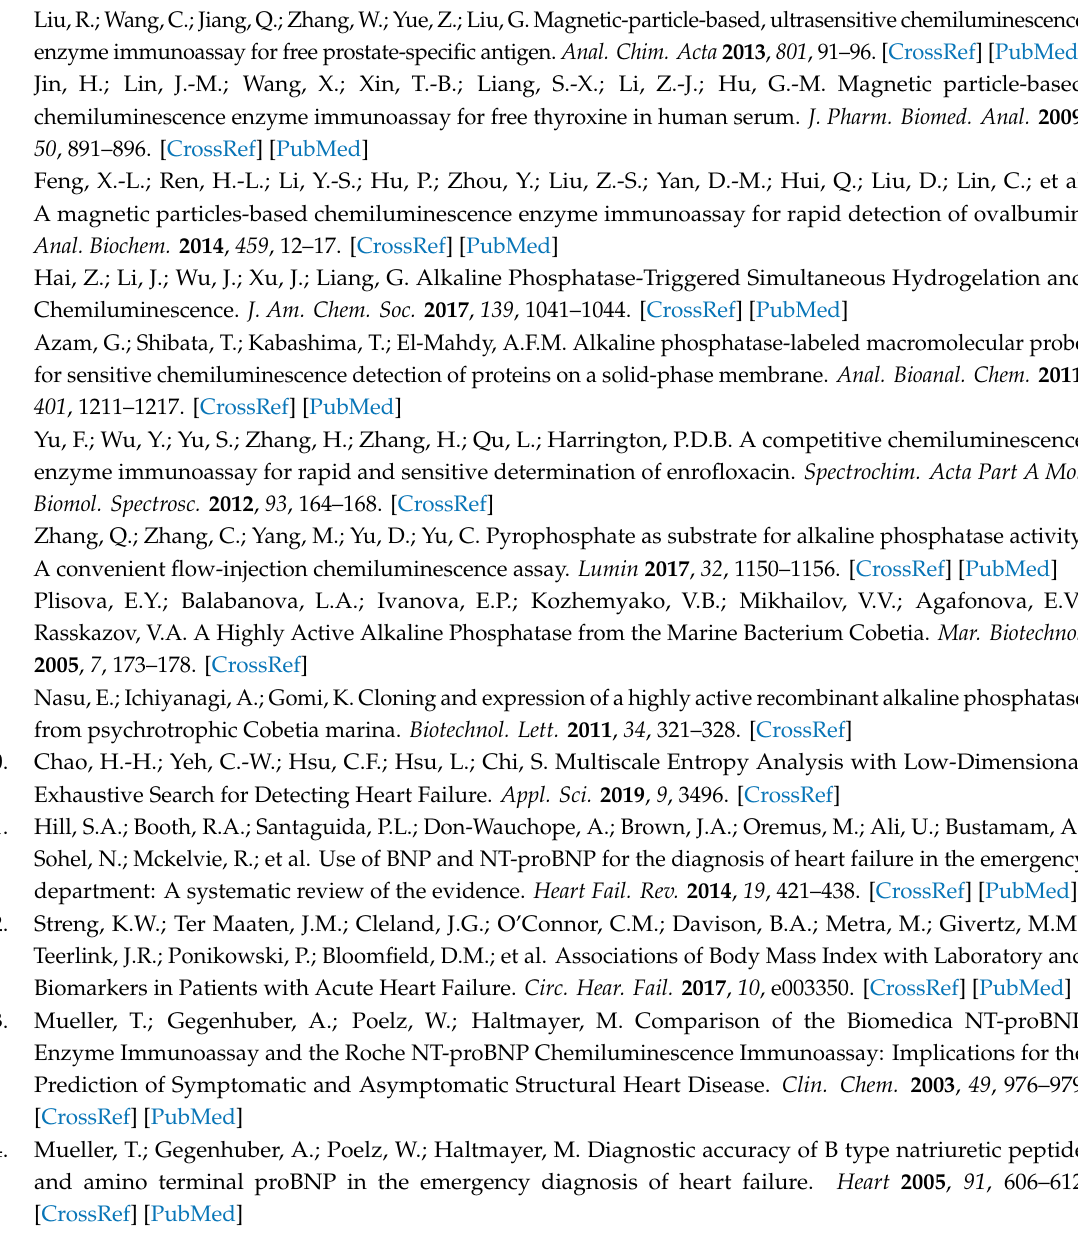
Figure S1: Coomassie-blue stained SDS-PAGE gel profile (12%) of di ff erent purified alkaline phosphatase, Figure S2: The e ff ect of pH on the relative activity of purified CmAP, Figure S3: The e ff ect of temperature on the relative activity of purified CmAP, Table S1: The chemiluminescence values of blank sample, Table S2: The recovery rate of NT-proBNP tested in normal human serum, Table S3: The CV values of intra-assay and inter-assay. Table S4: Linearity-dilution e ff ect (diluted by horse serum), Table S5: Linearity-dilution e ff ect (diluted by DEA bu ff